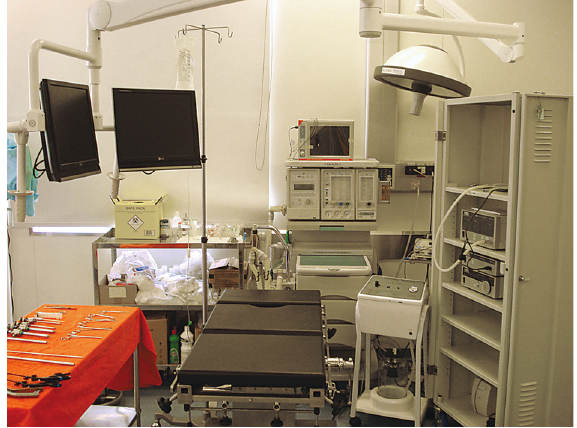
Figure 1 – View of the laparoscopy